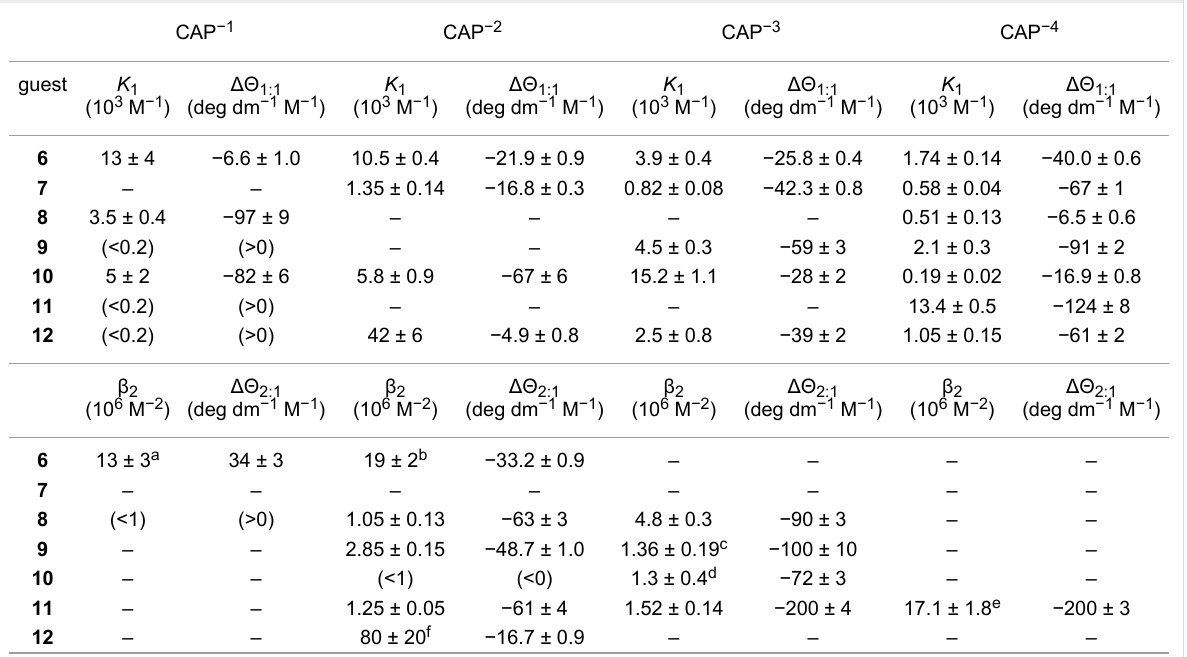
Table 1: Binding constants for CAP anions with guests 6 – 12